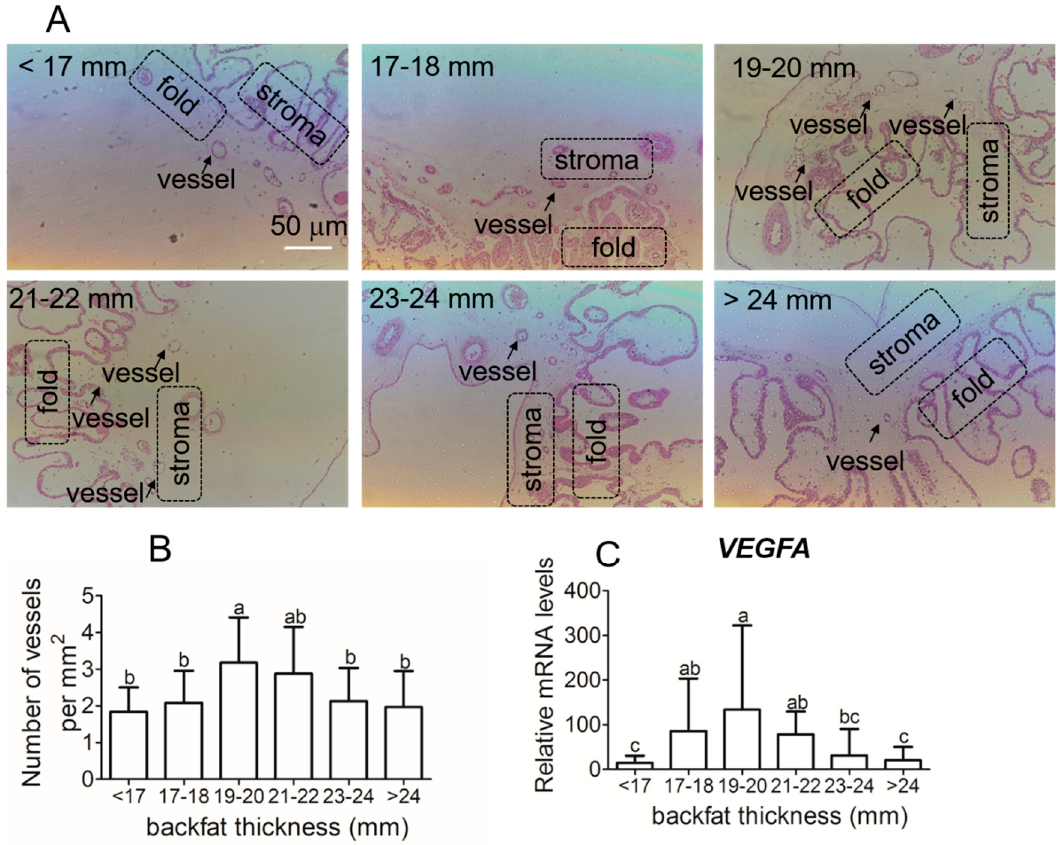
Figure 4. Average numbers of capillary per mm 2 placenta tissues and vascular endothelial growth factor (VEGF)A mRNA expressions in placenta tissue of different backfat thickness sows. ( A ) placenta tissue slices. ( B ) to quantify villous capillary density. ( C ) VEGFA mRNA expressions. Each group had 10–12 sows, and 4–5 placenta samples were analyzed per sow, mean ± SEM. Different letter showed significant difference ( p < 0.05). The arrows indicate the placental vessels in stroma (200× magnification).